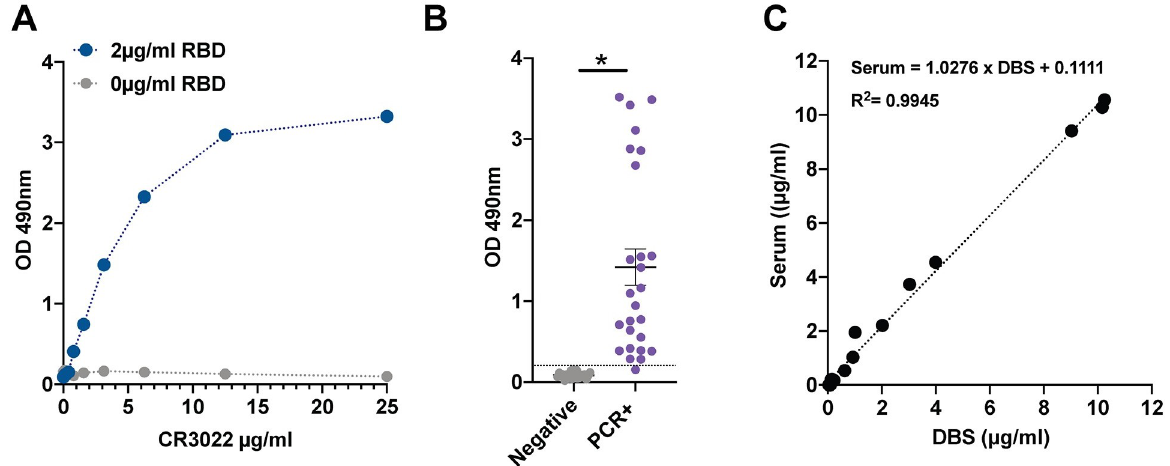
Fig 1. Dried blood spot (DBS) ELISA for the receptor binding protein domain of the SARS-CoV-2 spike protein. A) The CR3022 antibody has known reactivity to the receptor binding domain protein. Measurements from DBS samples to which known concentrations of CR3022 antibody were added. B) Increased signal readily detected in DBS from virus-positive cases. C) Near perfect correlation between DBS and serum IgG levels. � p < 0.001.